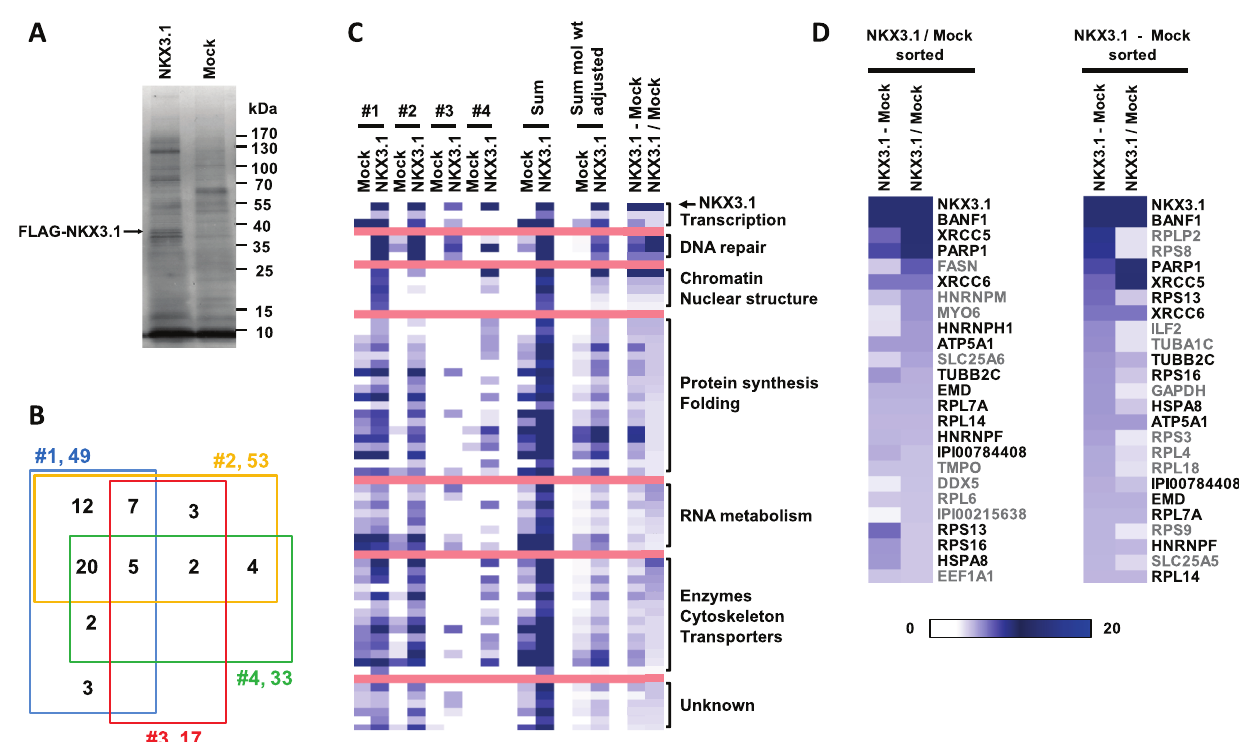
Figure 1. The NKX3.1 protein interactome. ( A ) Representative purification of FLAG-NKX3.1 from transfected LNCaP cells. Cell lysates were absorbed to anti-FLAG M2 resin, and specifically retained proteins were eluted with FLAG peptide and separated by SDS-PAGE. A band migrating with the expected molecular weight of FLAG-NKX3.1 and absent from the mock purification (empty vector) is highlighted. ( B ) Four- way Venn diagram to indicate the degree of overlap in the protein content detected in four independent purifications of FLAG-NKX3.1. ( C ) Map of spectrum count intensities in the four independent FLAG-NKX3.1 and mock purifications. The map also contains the sum of spectrum counts across all purifications as well as summed data after adjustment for protein molecular weights. The right most two columns present two distinct ways of background correction, either by subtracting mock values from NKX3.1 values (NKX3.1 – Mock) or by calculating the factor of enrichment in the NKX3.1 sample over mock (NKX3.1/Mock). See the Materials and methods section for details on data analysis and processing. ( D ) Spectrum count intensity maps of the 25 most abundant components of the NKX3.1 interactome. Data were sorted either by factor of enrichment (left panel, NKX3.1/Mock sorted) or by background subtracted values (right panel, NKX3.1 – Mock sorted). Black type font indicates the proteins occurring on both lists independent of the method of abundance-based